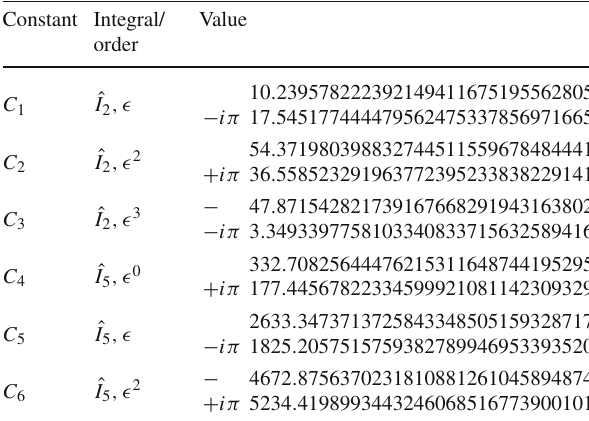
Table 1 Values of the constants determined by evaluating the analytic result for the MIs with GiNaC . The condition imposed in order to fix the constants is that integrals I 2 and I 5 vanish in the t → 1 limit. The second column indicates the MIs used to fix a given constant and the power n at which the constant first appears as a cofactor of (cid:3) n . In the last column one can find the complex value of the constant, which can in principle be determined at arbitrary precision Constant Integral/ order